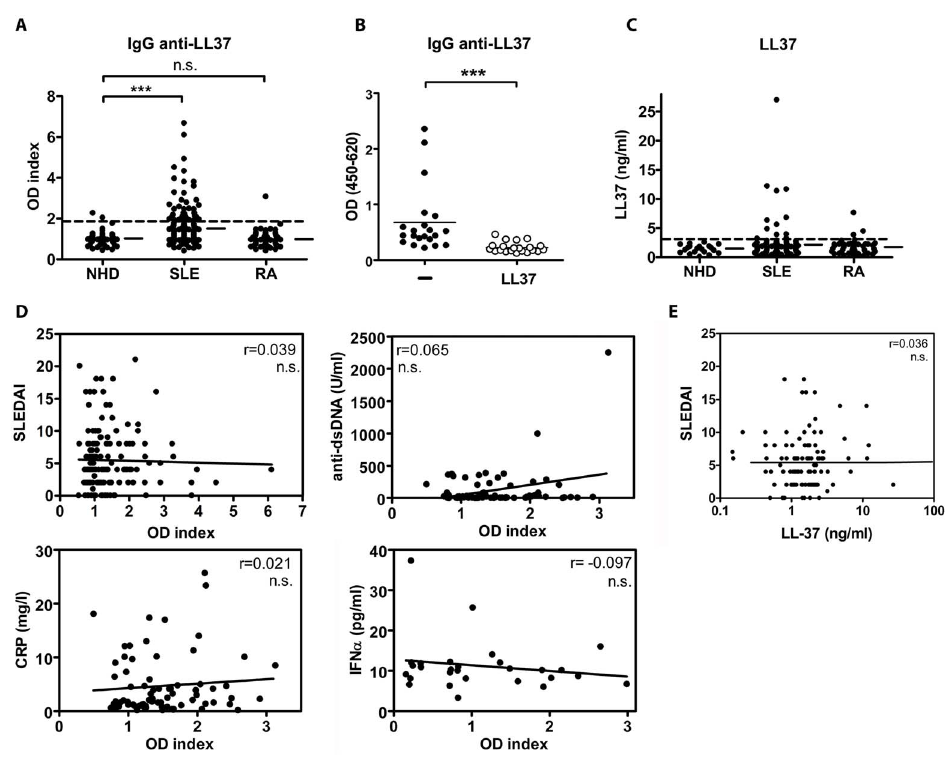
Fig. 1. Autoantibodies against LL-37 in SLE are not linked to disease activity. (A) In patients with SLE (n 5 185) but not with RA (n 5 92) or normal healthy donors (NHD, n 5 74) serum autoAbs to LL-37 are detected. Shown are optical density (OD) indices, which are the ratios of the OD in the individual donor to the mean OD in NHD sera. One dot represents one patient, horizontal bars show the means. ***P , 0.001, as determined by Kruskal-Wallis test with Dunn’s post-hoc test. Dashed line shows cutoff OD (1,93). (B) Sera of SLE patients (n 5 21) were preincubated with saturating concentrations of LL-37 peptide before reactivity to plate-bound LL- 37 was determined by ELISA. IgG reactivity to LL-37 can be blocked by preincubation with LL-37 peptide. ***P , 0.001, as determined by Mann-Whitney U test. (C) Serum levels of LL-37 peptide are raised in a subgroup of SLE and RA patients. One dot represents one donor. Dashed line shows cutoff OD (2,77 ng/ml). (D) No correlation is found between SLE anti-LL-37 autoAbs and disease parameters of SLE. X-Y scatter plots of correlations between OD indices of anti-LL-37 autoAbs in SLE patients and SLEDAI (n 5 163), anti- dsDNA autoAbs (n 5 73), or serum levels of C-reactive protein (CRP, n 5 74) or of IFN a (n 5 28), respectively. Spearman coefficients (r) are depicted within the graphs. N.s., not significant. (E) Serum levels of LL-37 peptide are not linked to SLE disease activity. X-Y scatter plot of correlation between serum LL-37 levels and SLEDAI in 110 patients with SLE. Spearman coefficient (r) is depicted within the graph. N.s., not